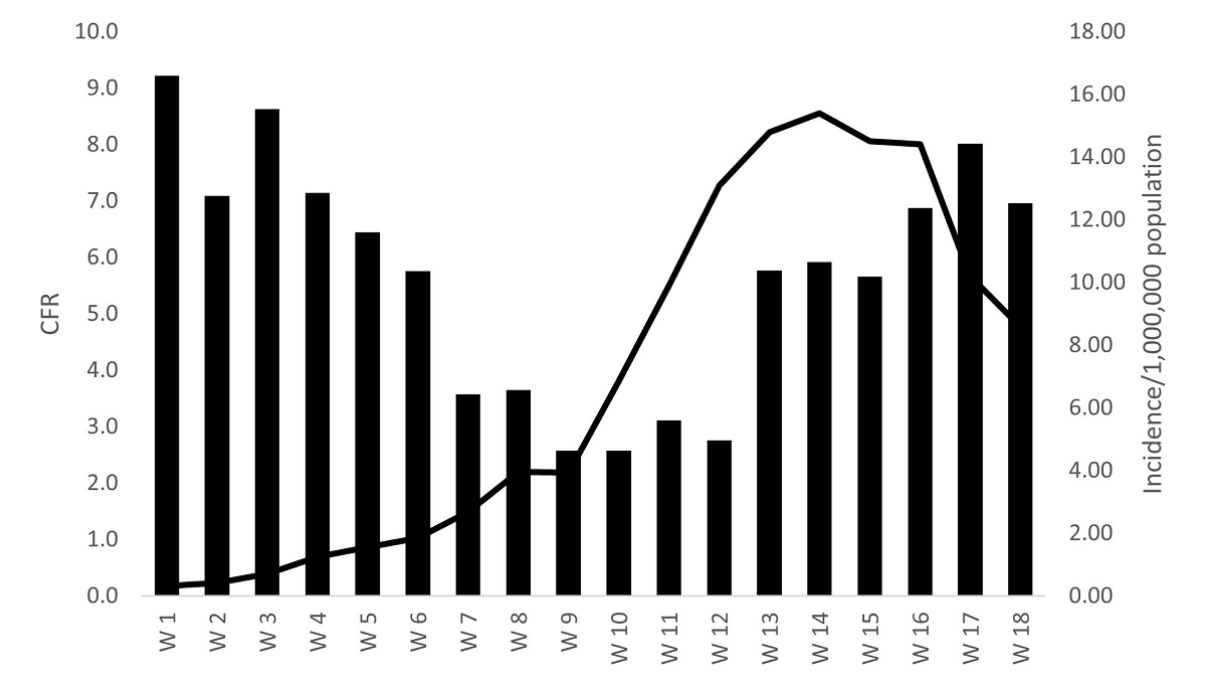
Figure 3. COVID-19 incidence rate and case fatality rate in Egypt, February to July 2020. Source: Ministry of Health and Population daily COVID-19 report. CFR: case fatality